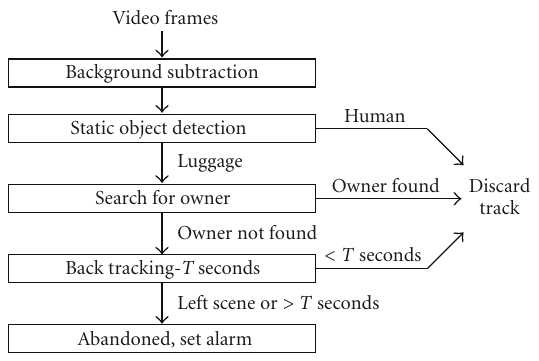
Figure 1: System work